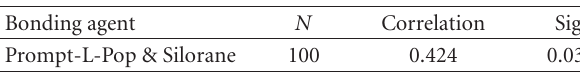
Table 5: Paired samples